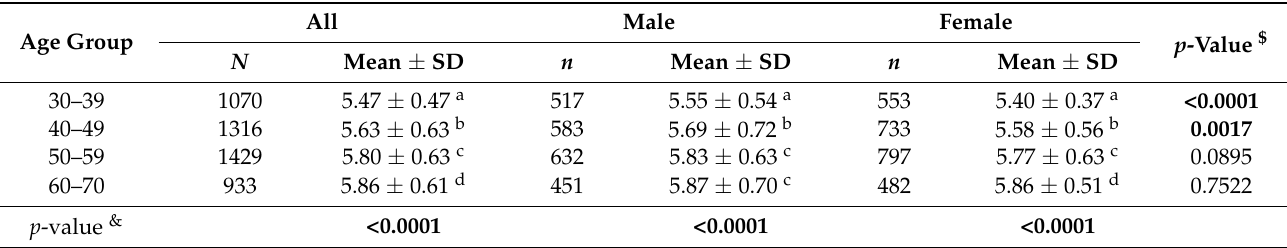
Table 3. HbA1c levels between sexes for different age